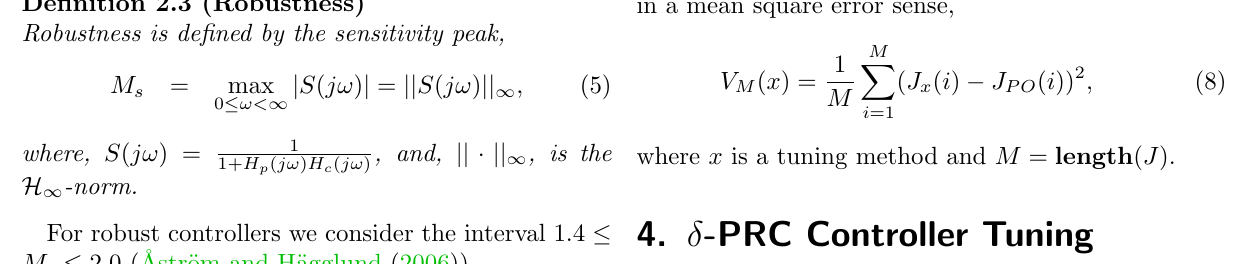
Algorithm 2.1 in Dalen and Di Ruscio (2018),